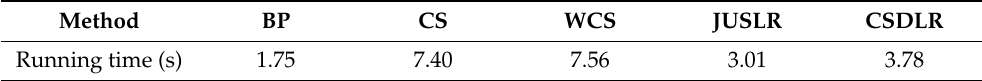
Table 4. Comparison of running time of different imaging methods in measured data